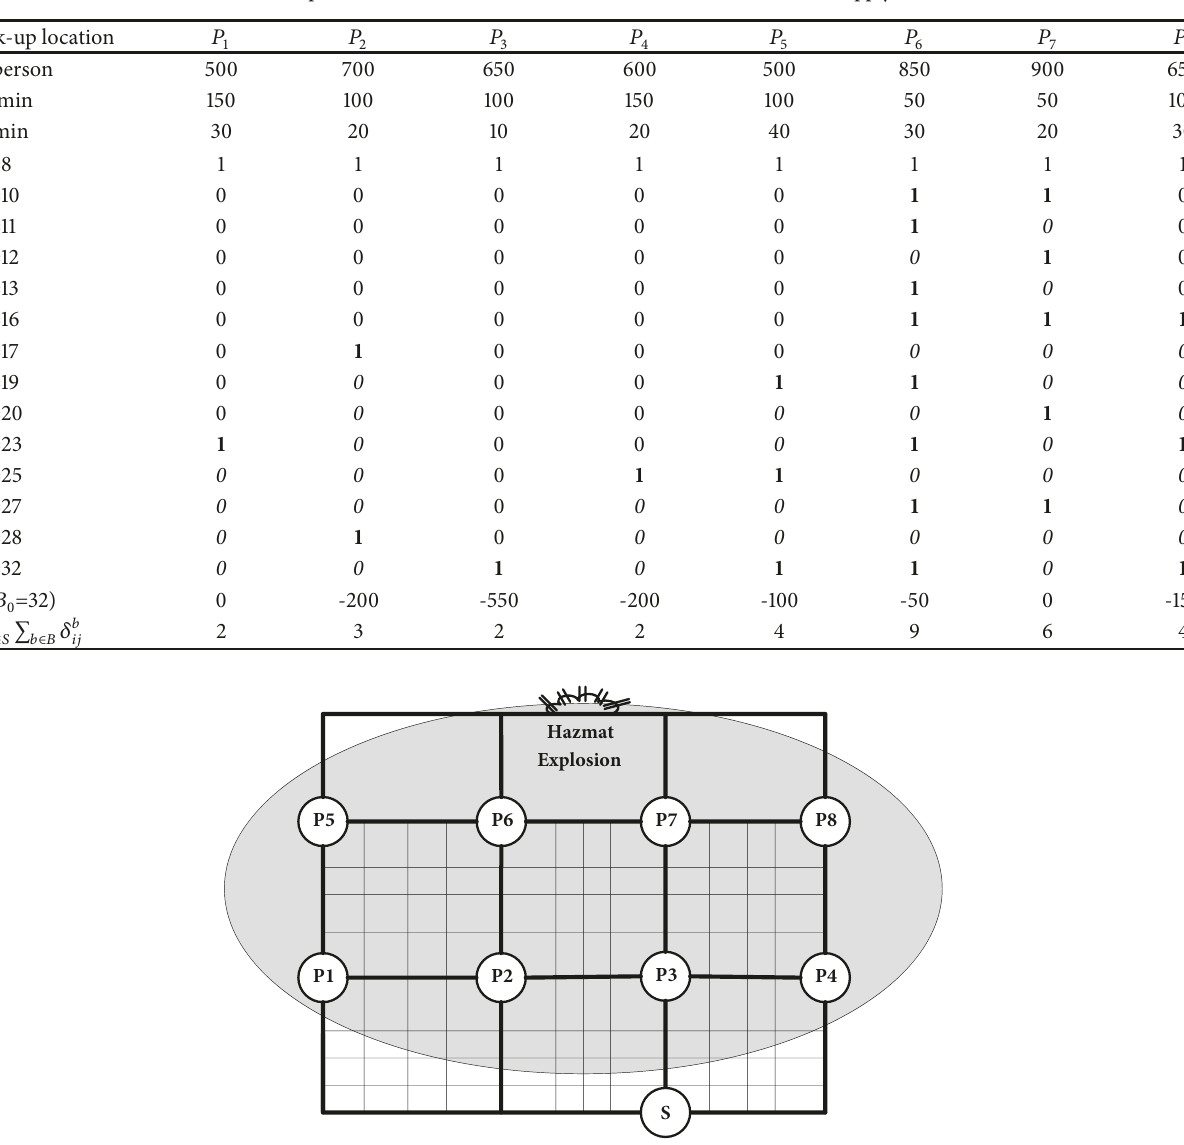
Table 1: Pick-up location attributes and bus schedule scheme for different supply conditions.